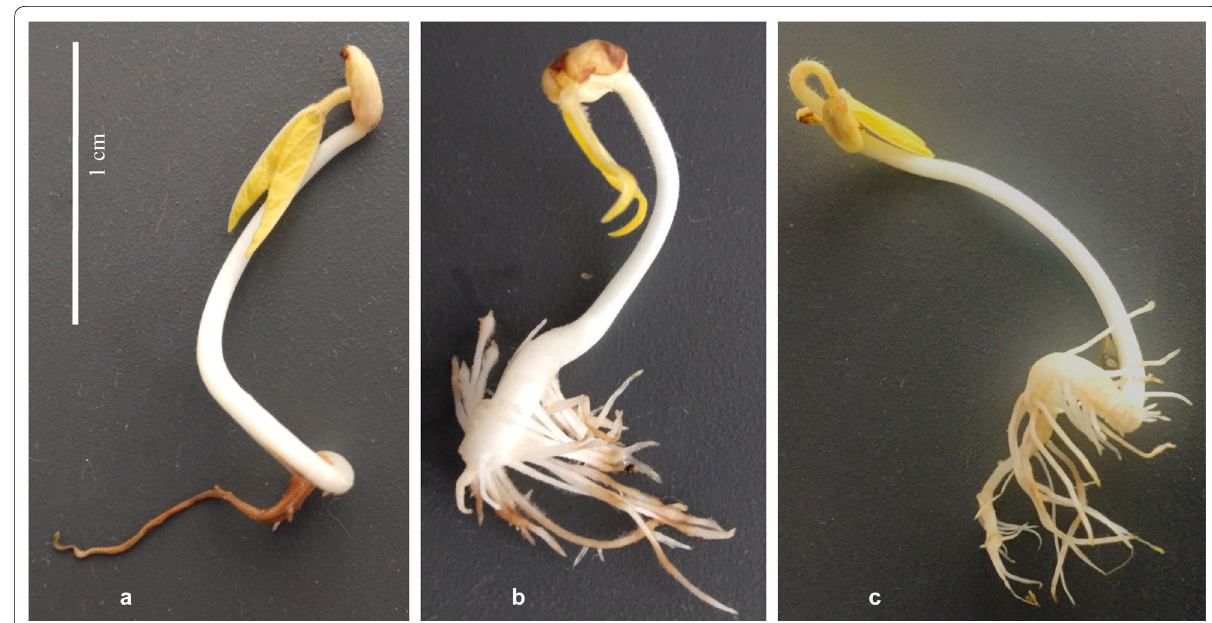
Fig. 5 Comparison of V. radiata seedlings: a control, b treated with crude IAA, c treated with purified